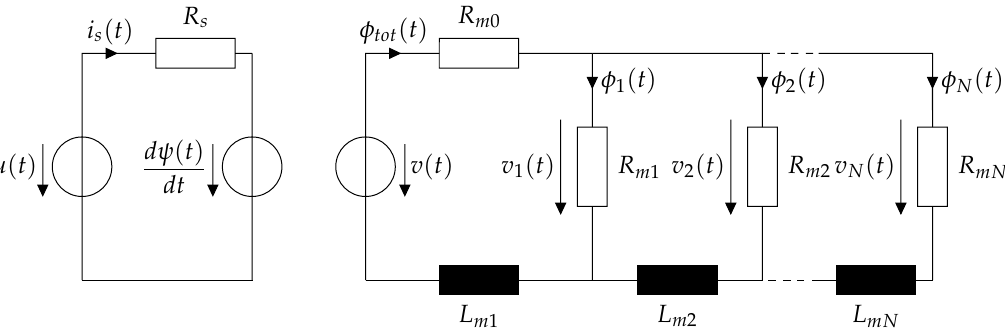
Figure 2. Full electromagnetic equivalent circuit of a solenoid actuator including cascades of reluctances and magnetic inductances representing the eddy